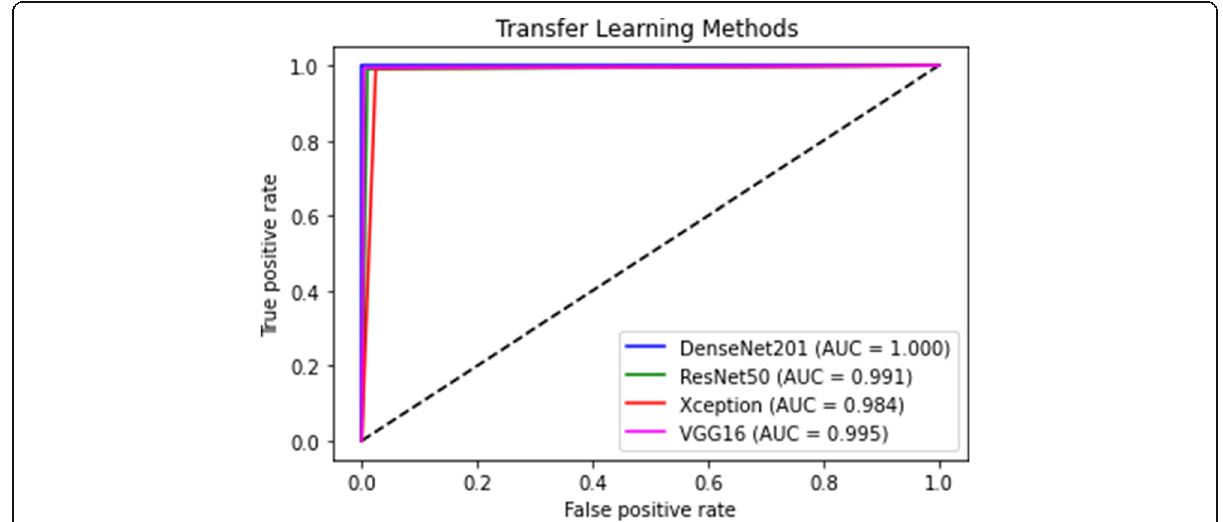
Fig. 6 ROC plots of the pre-trained models